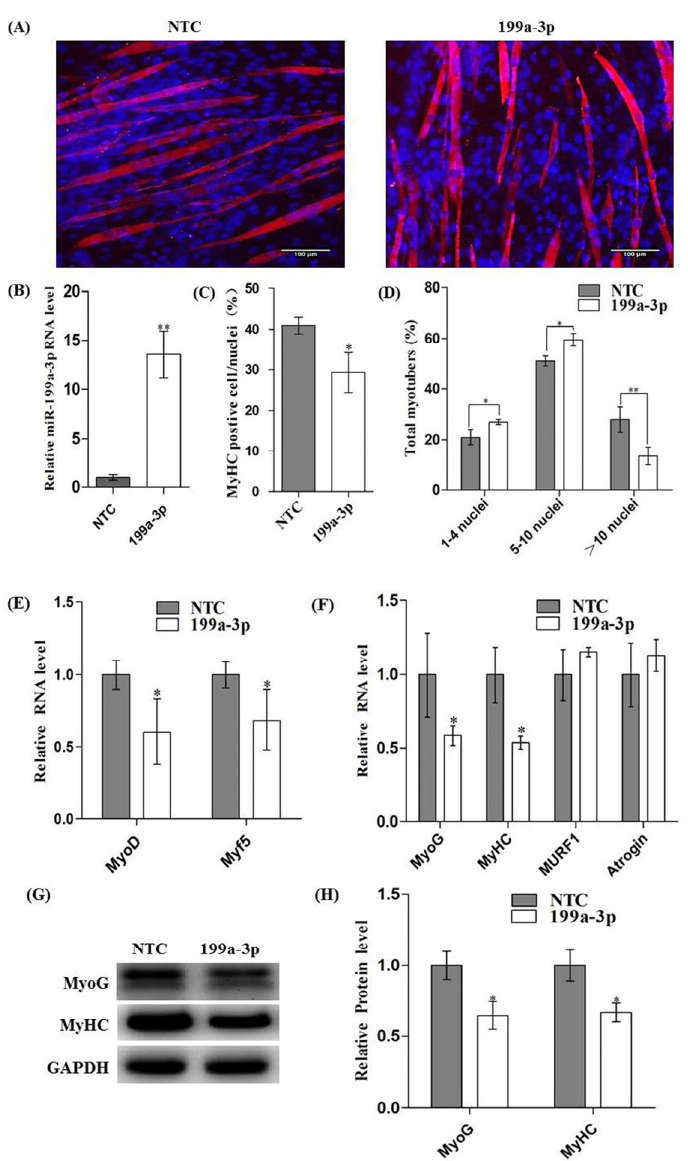
Figure 3. Overexpression of miR-199a-3p inhibited C2C12 myogenic differentiation. C2C12 cells were transfected with miR-199a-3p Mimics (or negative control miRNA) and grown in growth medium (GM) for 12 h, then induced to myogenic differentiation with differentiation medium (DM). At the 96 h of differentiation: ( A ) Immunofluorescence of muscle myosin heavy chain (MyHC) in C2C12 myotubes; ( B ) The over-expression efficiency was measured by real-time qPCR; ( C ) The fusion index was counted by MyHC-positive cells to total nuclei (Hoechest-positive cells); ( D ) Myotubes sizes were determined by myonuclei counts in myotubes transfected with miR-199a-3p mimic or negative control miRNA; ( E ) Relative mRNA levels of MyoD and Myf5 were detected by real-time PCR at the 24 h of differentiation; ( F ) Relative mRNA levels of MyoG, MyHC, MURF1 and Atrogin1 at the 96 h of differentiation; ( G ) Western Blot detected the protein expression of myogenic markers MyoG, and MyHC at the 96 h of differentiation; and ( H ) The relative protein levels in ( G ) were analyses using image J. Results are presented as mean ± S.E.M. n = 3. * p < 0.05, ** p <